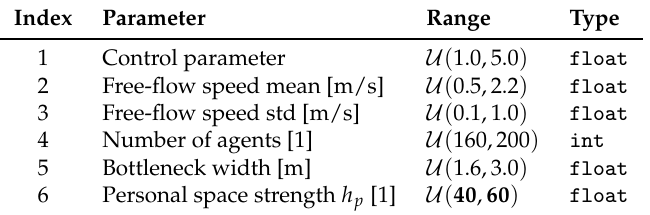
Table A2. Uncertain parameters and their distribution used for the sensitivity analysis.